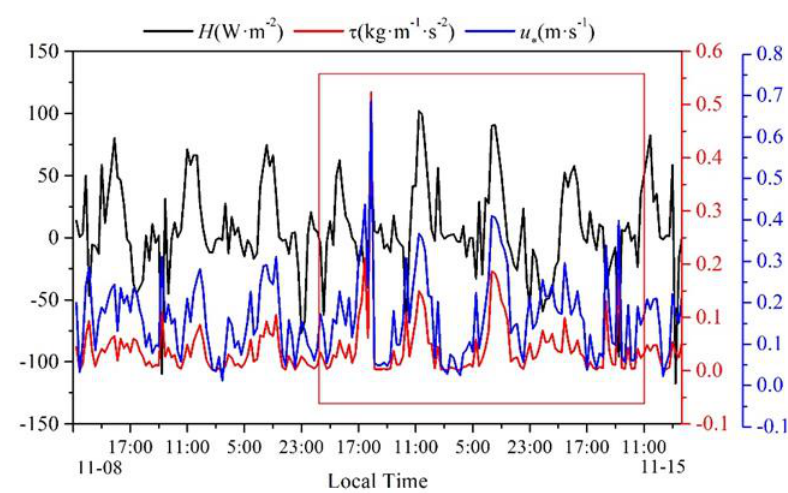
Figure 5. Sensible heat flux ( H ), momentum flux ( τ ), and friction velocity ( u * ) measured during the observation periods at Tazhong in the TD (Red box is dusty weather period).